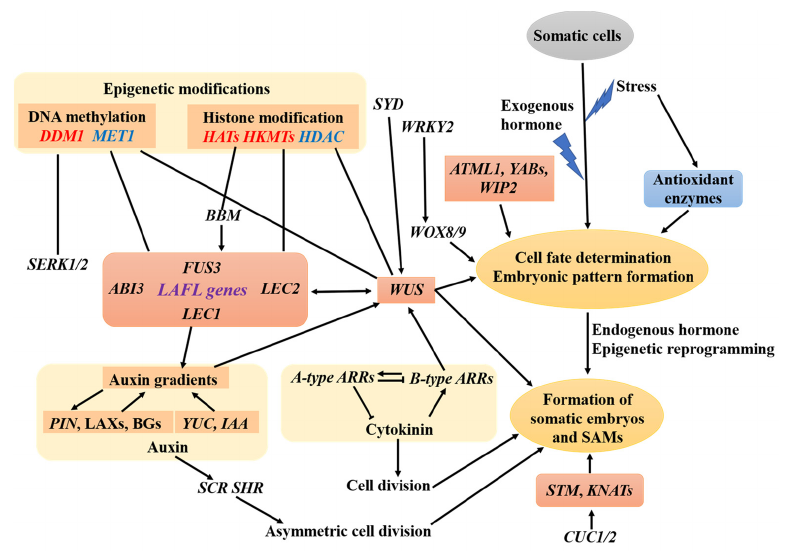
Figure 9. A model of a molecular regulatory network during tree peony somatic embryogenesis. Black arrows indicate positive regulation. Black lines without arrows mean either positive or negative regulation. Genes marked red related to epigenetic modification accelerate somatic embryogenesis, while genes marked in blue inhibit somatic embryogenesis.